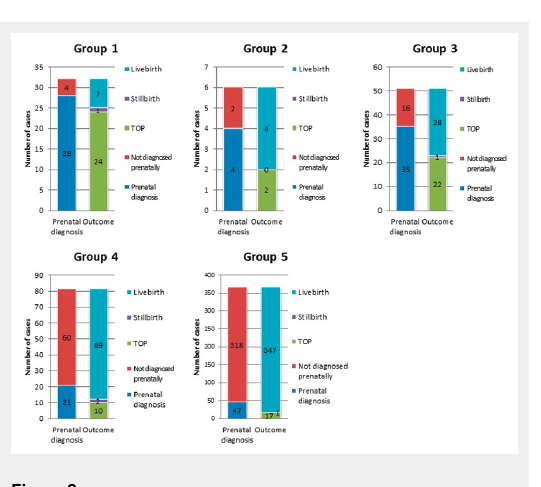
The outcomes of pregnancies in groups 1–5 (live birth or stillbirth, TOP for isolated CHD, or TOP for CHD associated with a chromosomal or syndromal anomaly).